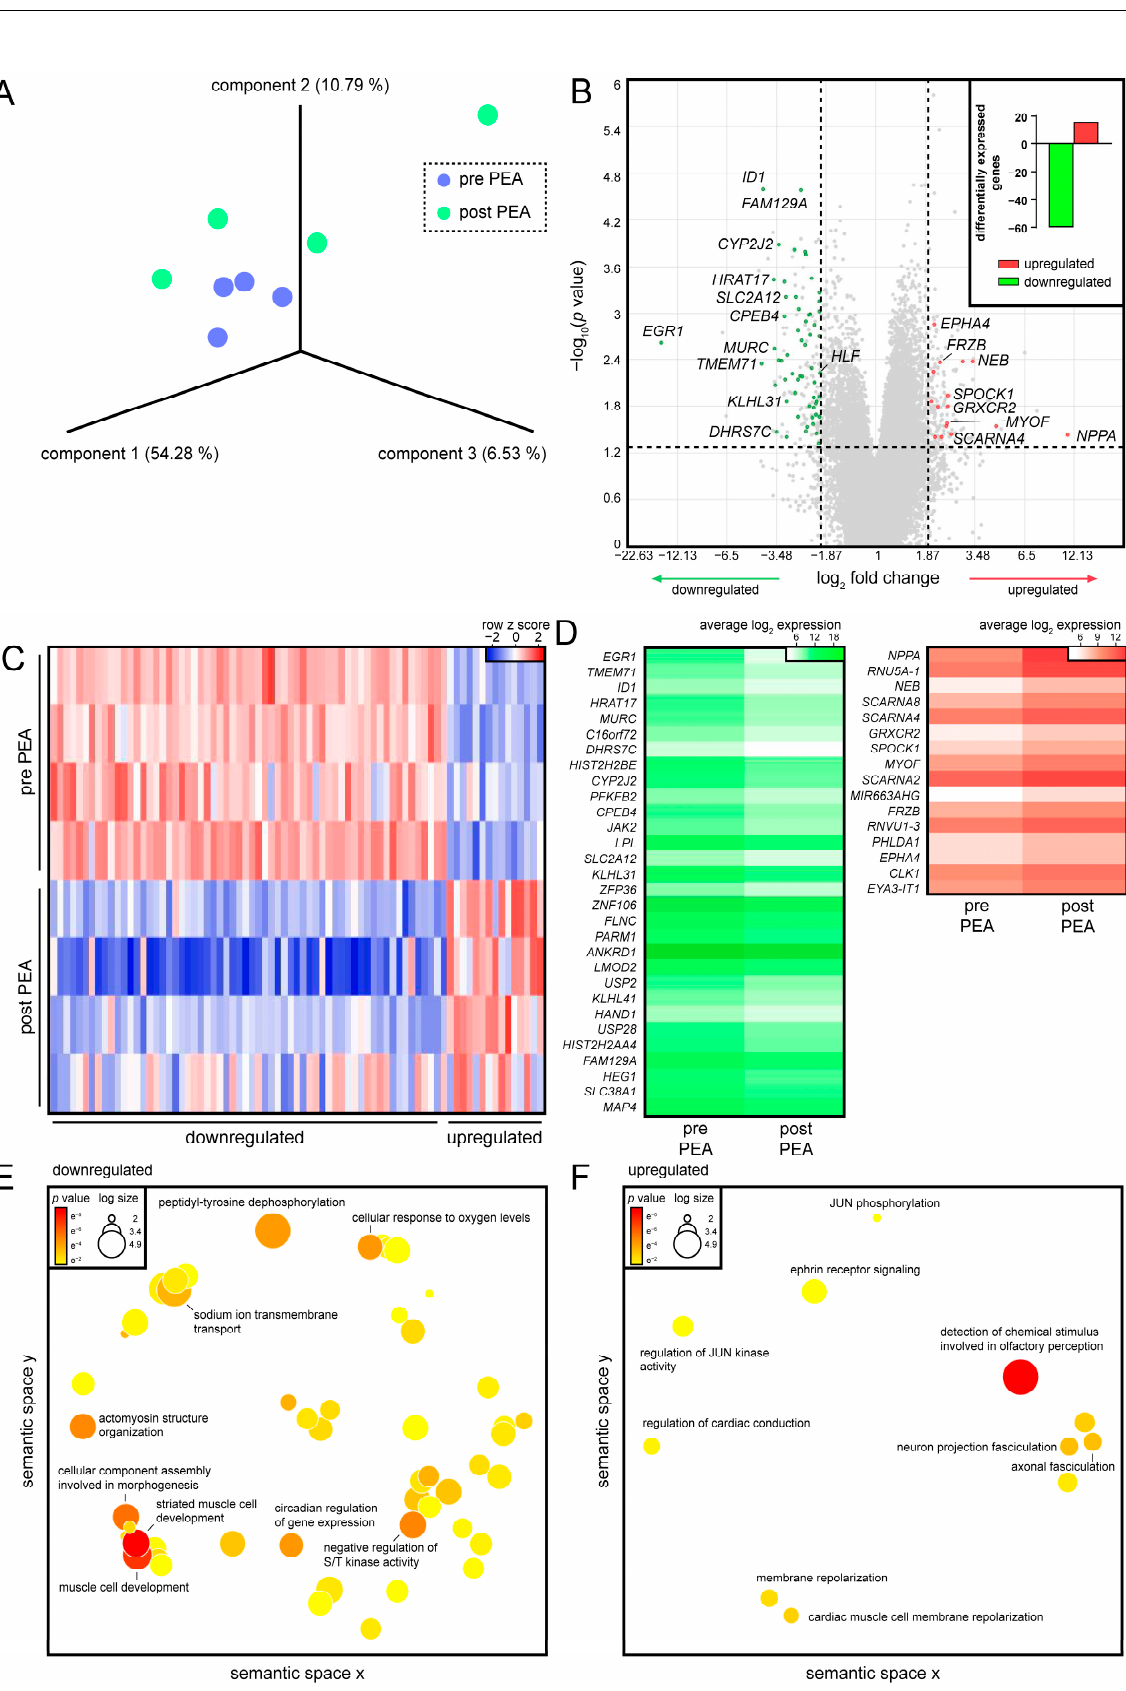
Figure 3. Gene expression profiles of hypertrophic myocardium of CTEPH patients before PEA and reverse remodeled hearts 3 months after surgery. ( A ) PCA of samples before PEA and 3 months